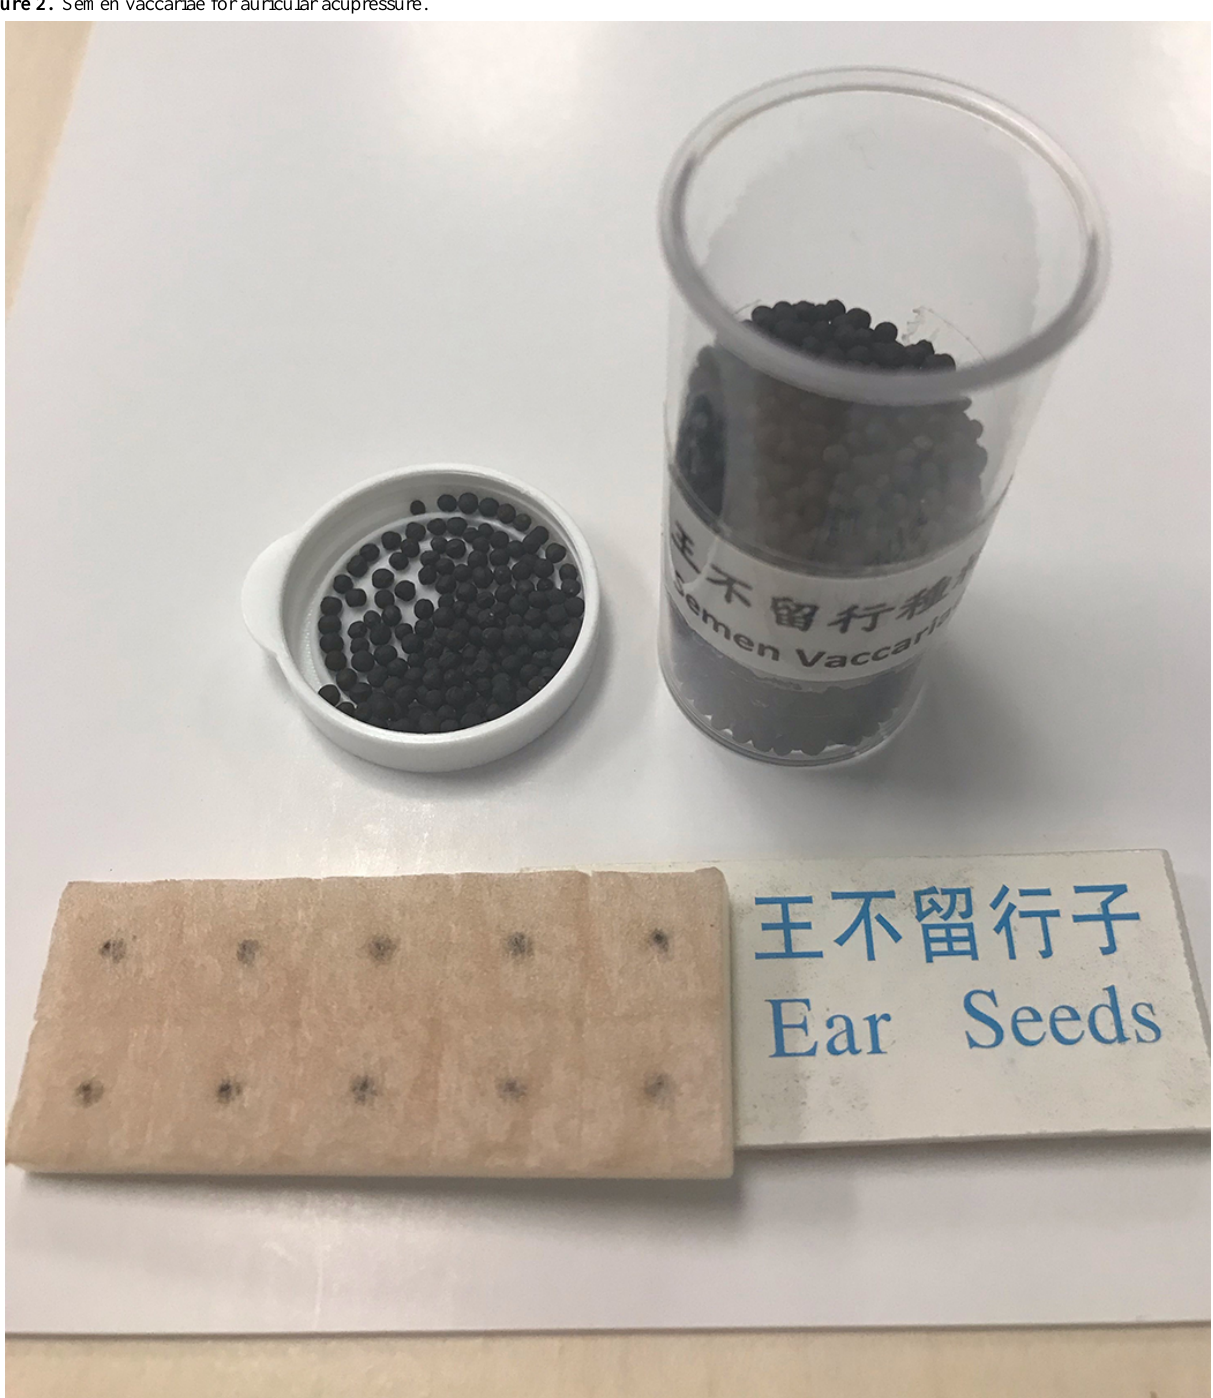
Figure 2. Semen vaccariae for auricular